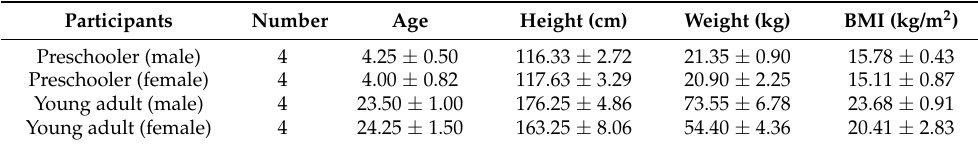
Table 2. Basic information for the two types of participants.